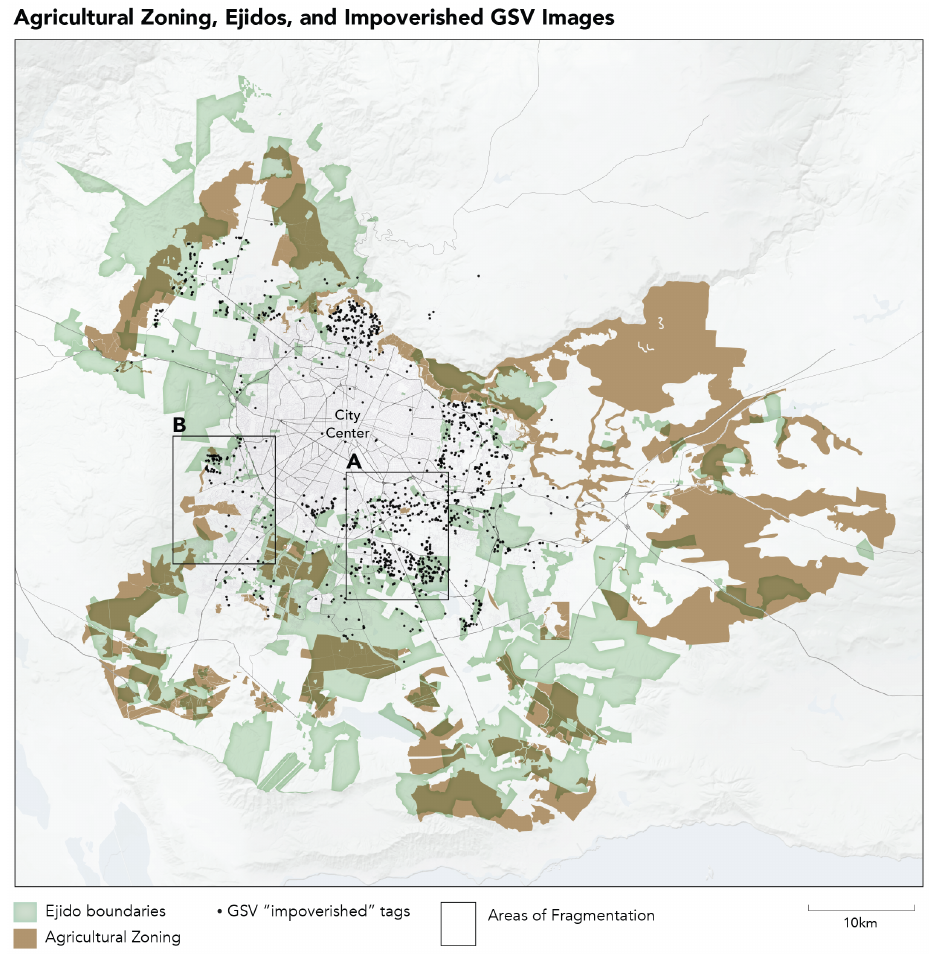
Figure 9. Agricultural zoning, ejidos, and impoverished-GSV